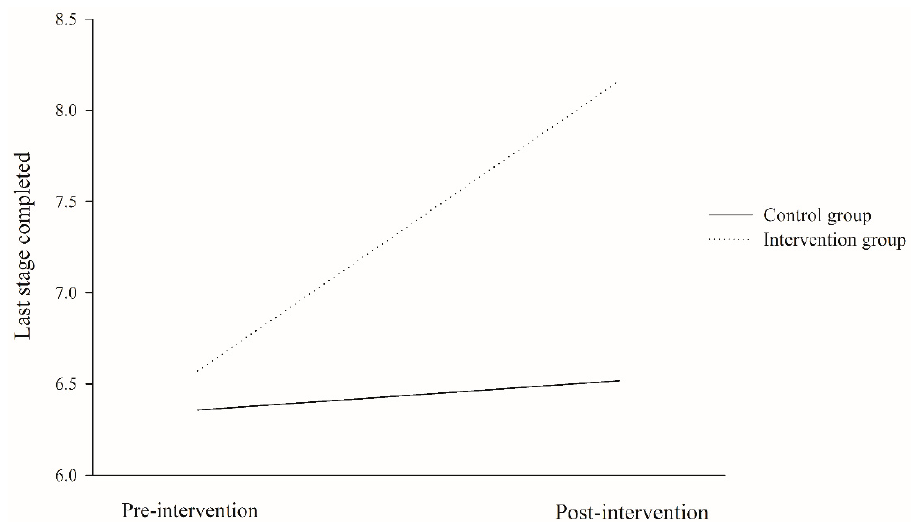
Figure 2. Changes in cardiorespiratory fitness level measured by last stage completed in 20-meters shuttle-run test for intervention and control group ( p < 0.001, for post-intervention differences between groups).